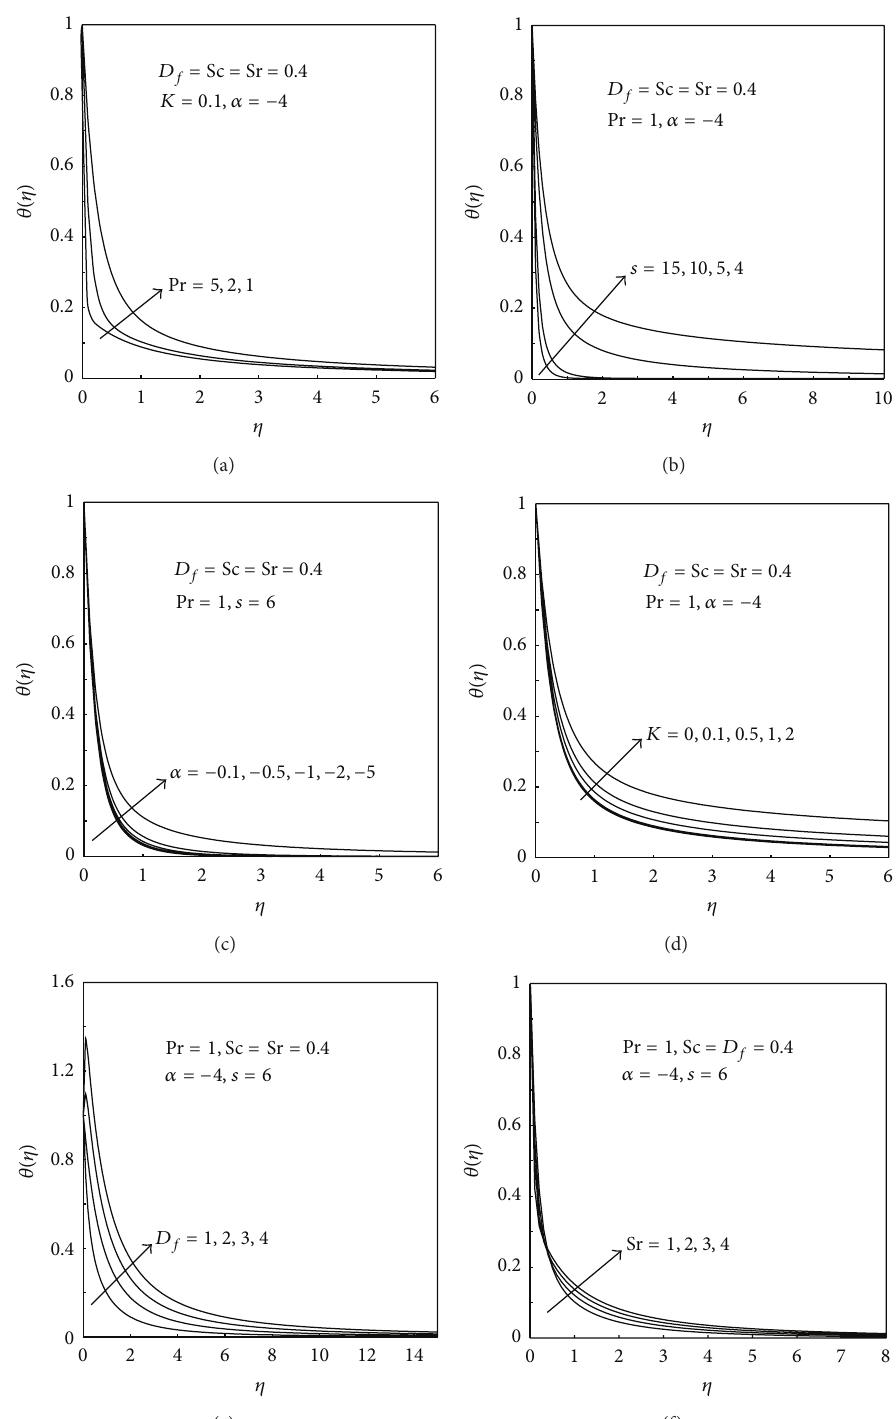
Figure 2: (a) Temperature profiles for a shrinking sheet problem under different values of Prandtl number. (b) Effects of the mass transfer parameter (mass suction) on the temperature profiles of a shrinking sheet. (c) Temperature profiles for different values of shrinking sheet strength with mass suction. (d) Effects of the permeability parameter on the temperature profiles of a shrinking sheet with mass suction. (e) Effects of Dufour number 𝐷 𝑓 on the temperature profiles of a shrinking sheet with mass suction. (f) Effects of Soret number Sr on the temperature profiles of a shrinking sheet with mass